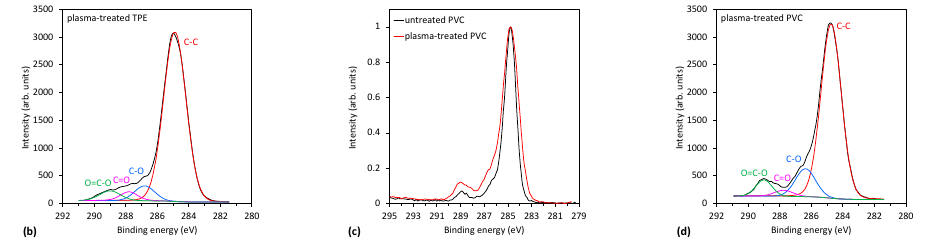
Figure 6. ( a , c ) Comparison of C1s peaks of untreated and two-step plasma-treated TPE and PVC catheters and ( b , d ) best fitting of C1s peaks with oxygen-containing functional groups for plasma- treated TPE and PVC catheters.